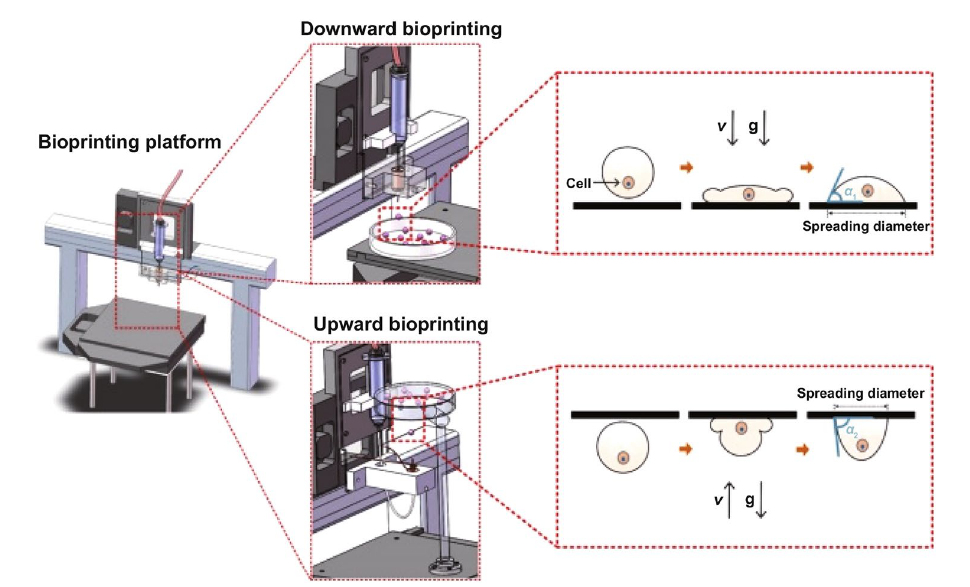
Fig. 11 A schematic illustration of the upward and downward bioprinting devices, as an advanced and high-resolution droplet-based bioprinting systems. Reprinted with permission from [130]. Copyright 2021 American Chemical Society printing technology for the direct droplet-based bioprinting of microvasculature. The modified inject bioprinter depos- ited smooth muscle cells and bovine aortic endothelial cells onto collagen and matrigel, respectively [134]. The cell via- bility was achieved after 3 days of in vitro